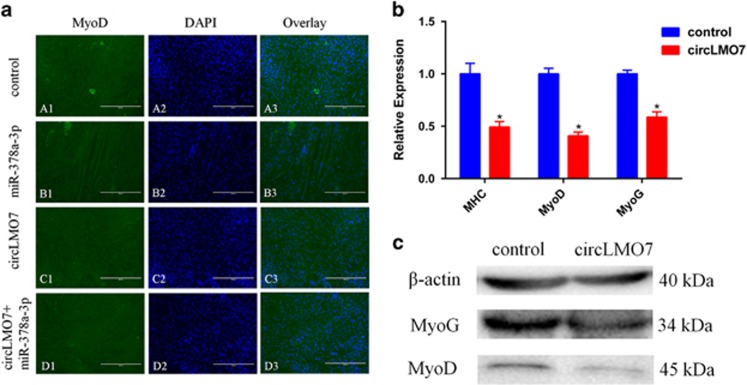
circLMO7 suppresses the differentiation of bovine primary myocytes. (a) Bovine primary myocytes were transfected with pcDNA-circLMO7 and/or miR-378a-3p mimic, and cell differentiation was detected by immunofluorescence. (b) mRNA of marker genes for myocyte differentiation were detected by qPCR. (c) The presence of proteins translated from marker genes of myocyte differentiation were analyzed using western blots